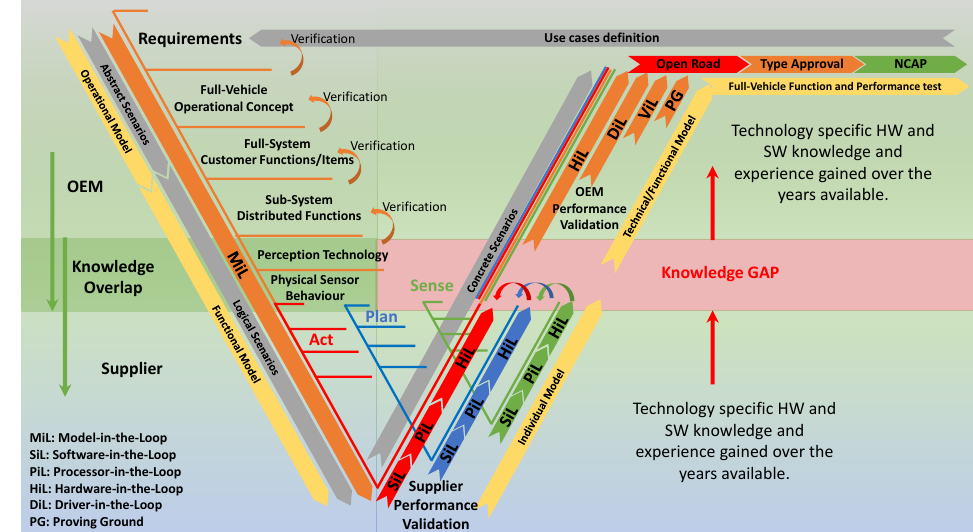
Figure 2. Vehicle development process with respect to driving